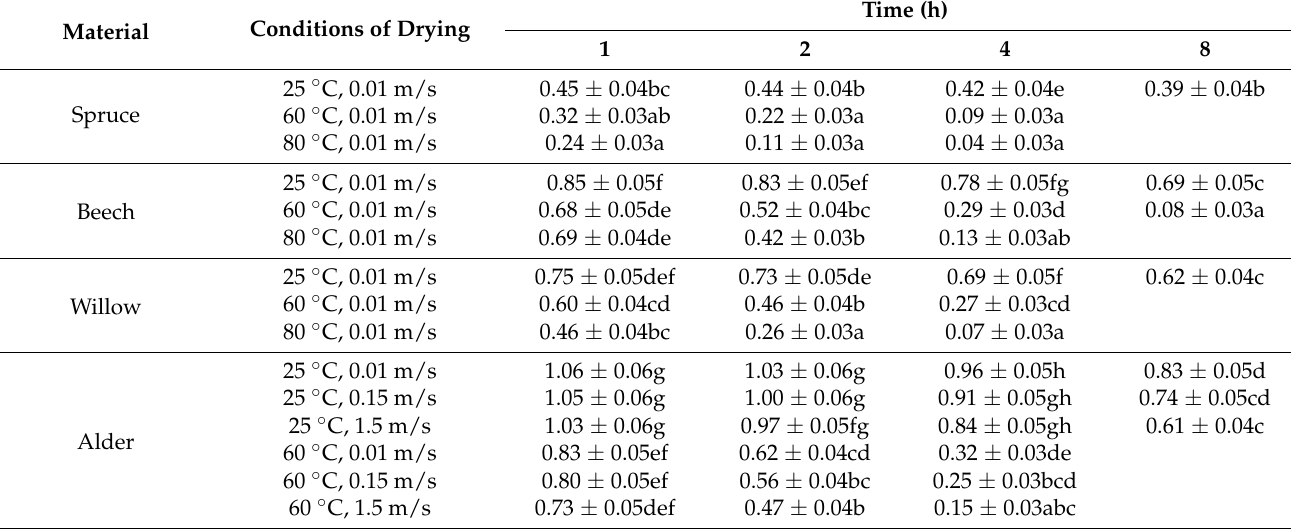
Table 2. Moisture content (kg H 2 O/kg d.m.) of sawdust (with standard deviation) in the drying process.